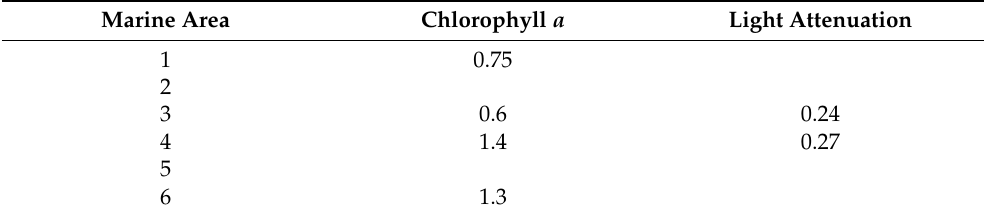
Table 7. Percentage changes in summer chlorophyll a concentrations and light attenuation in the different areas of Limfjorden that are due to changes in nutrient input in the scenario. No data indicate that nitrogen load was not selected as a controlling